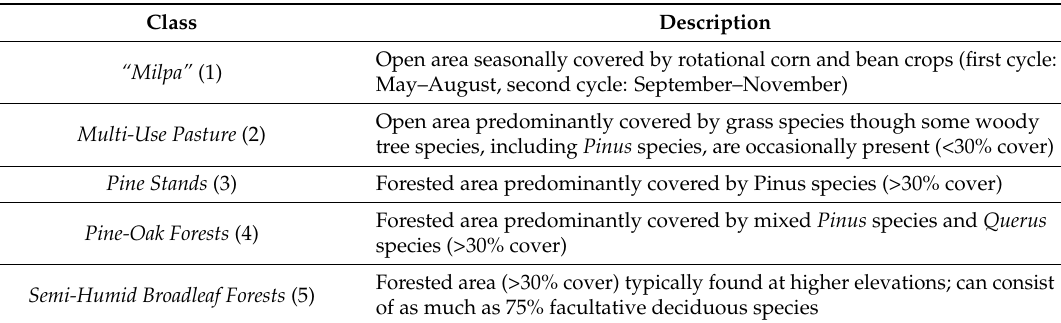
Table 2. Land-Cover